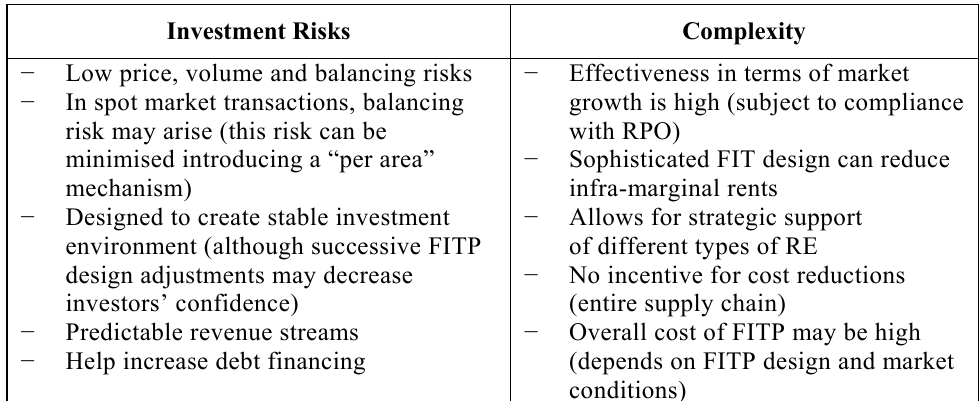
Table 1. Feed-in-Tariff Policy (World Bank,